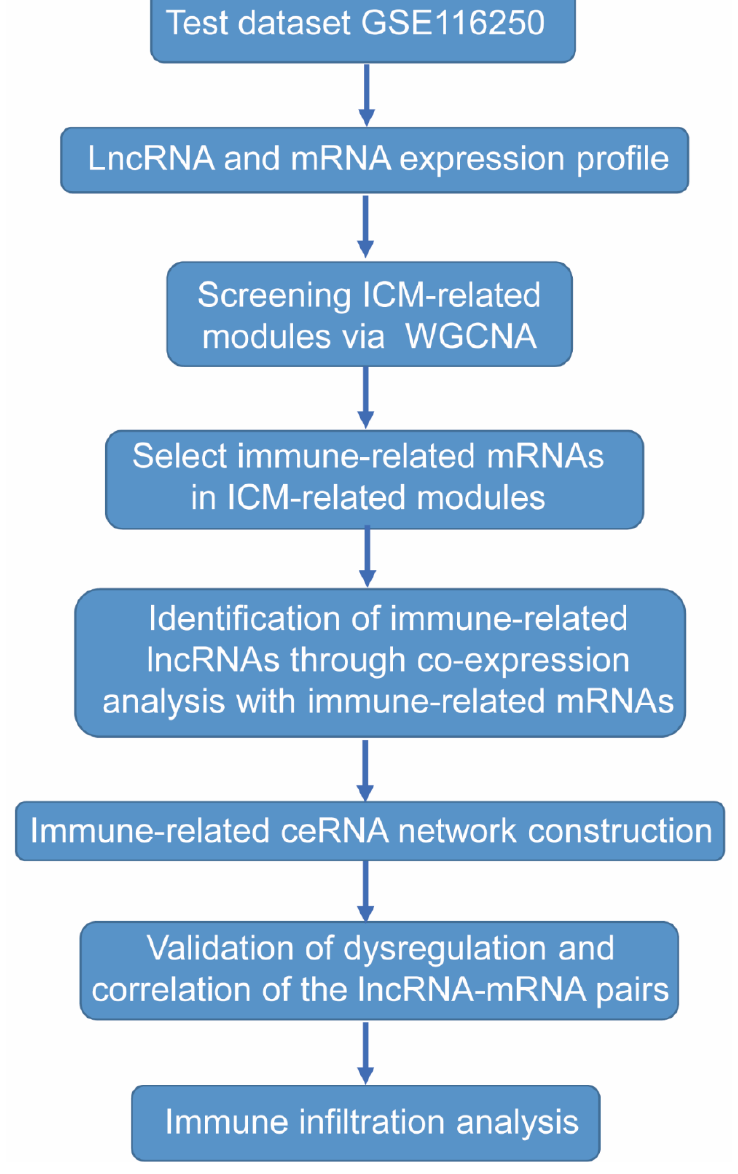
Figure 7. Study flowchart.